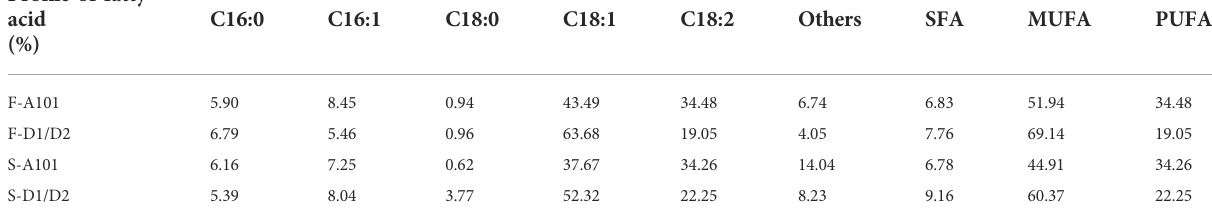
TABLE 1 Fatty acids pro fi le of the strains A101 or AJD DGA1/DGA2 grown on F. vesiculosus (F) or S. latissima (S) hydrolysates. Pro fi le of fatty